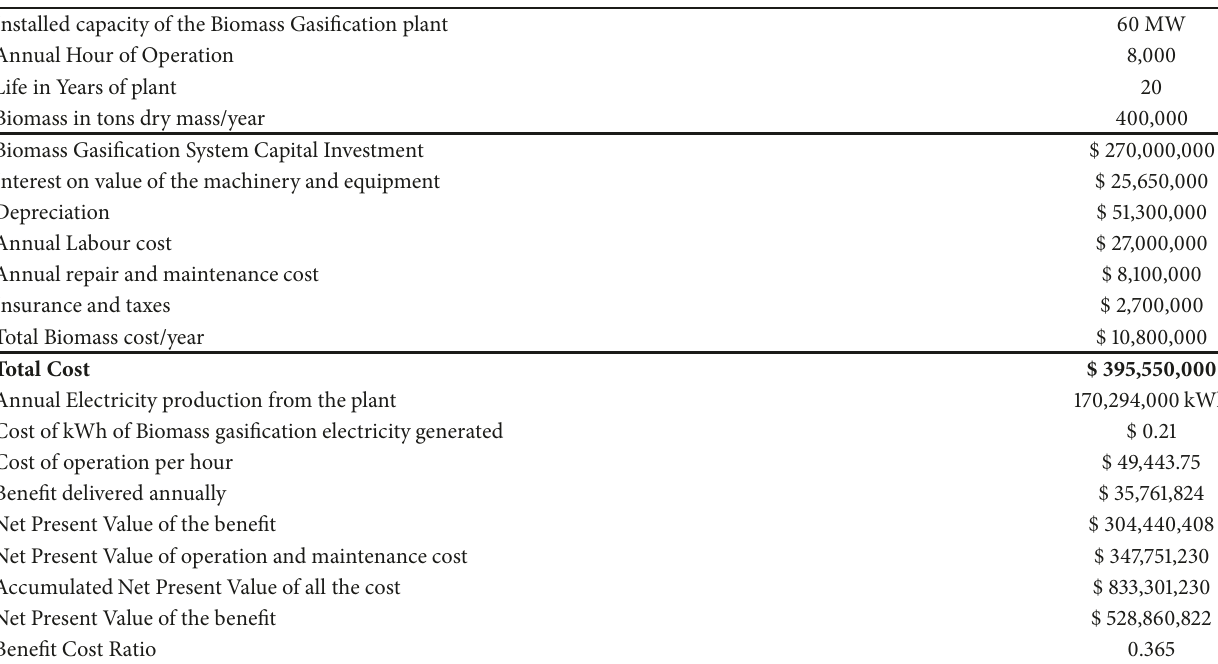
Table 16: Estimated cost structure of biomass gasification